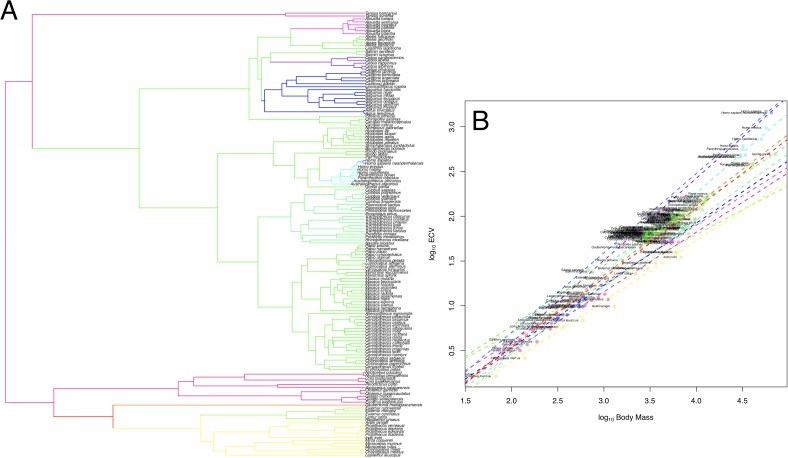
OU Model of ECV Evolution in Primates Results are shown for the un-weighted predictor OU model of ECV predicted by body mass.Figure 1 displays the same results, but only for great apes. Panel A shows the location of the selection regimes. Panel B shows the optimum regression lines representing the various selection regimes, along with body mass and ECV data. Data in panel B are colored according to the corresponding regimes shown in panel A.